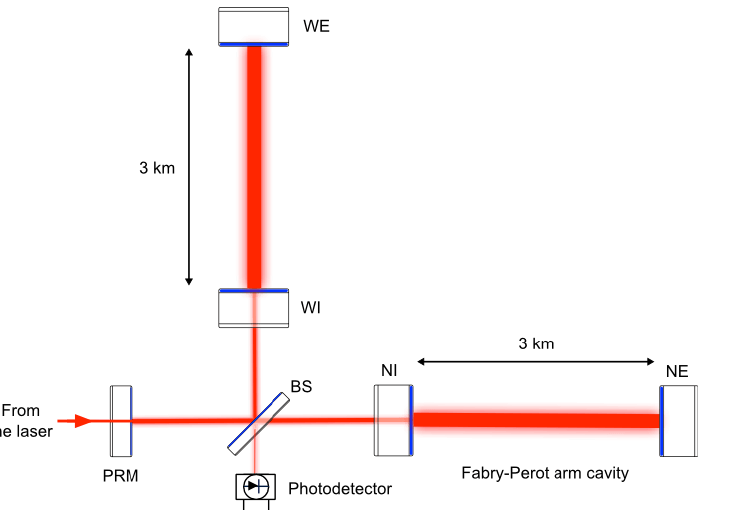
Figure 1. Optical system of Virgo detector (Credits: The Virgo Collaboration).